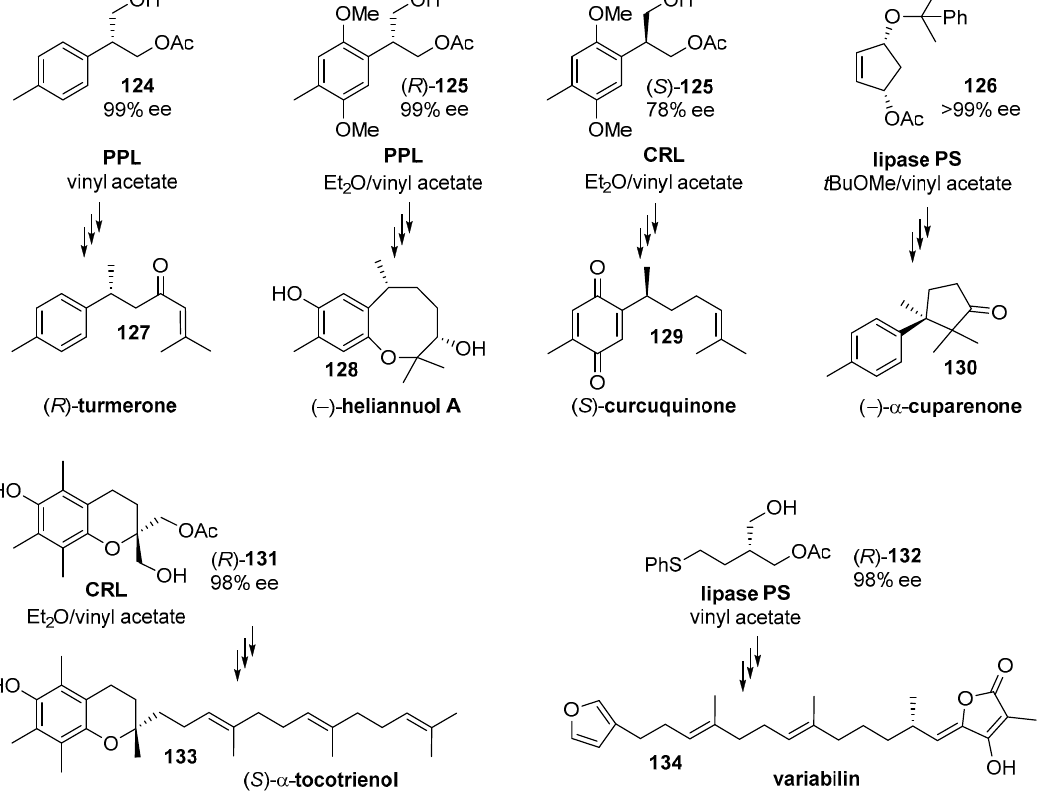
Figure 18. Lipase-mediated desymmetrization of meso compounds. The figure describes the enantioenriched compounds obtained by desymmetrization ( 124 , ( R )- 125 , ( S )- 125 , 131 , and 132 ) and resolution ( 126 ), the lipase used (below chemical structure), and the terpene derivatives prepared by using the described chiral building blocks ( 127 – 130 , 133, and 134 ).